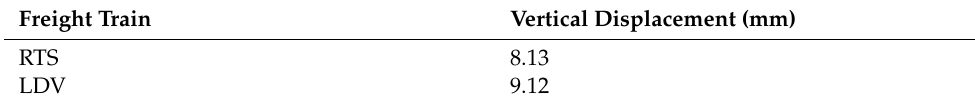
Table 5. Numerically evaluated vertical displacement results for Freight Train. Table 4. Numerically evaluated vertical displacement for Passenger Train.